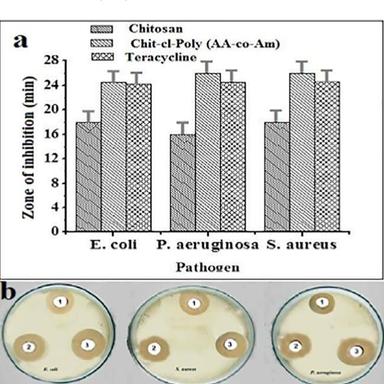
(a) Antibacterial activity of chitosan, chit-cl-Poly (AA-co-Am) against E. coli, P. aeruginosa and S. aureus bacteria. (b) Anti-bacterial the activity of chitosan and chitcl-poly (AA-co-Am) against the E. coli, S. aureus, and P. aeruginosa compared to standard marketed drug tetracycline.